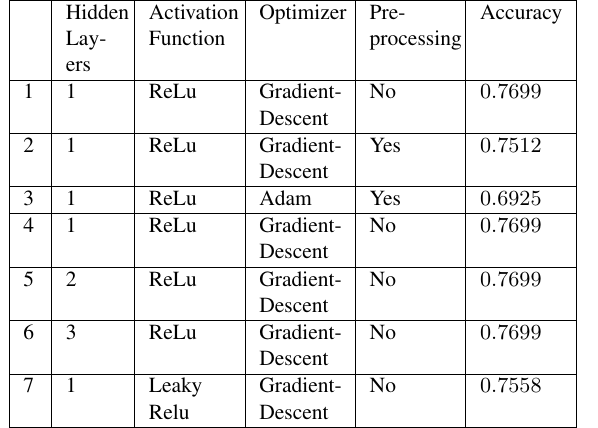
Figure 3. Time series of number of small earthquakes